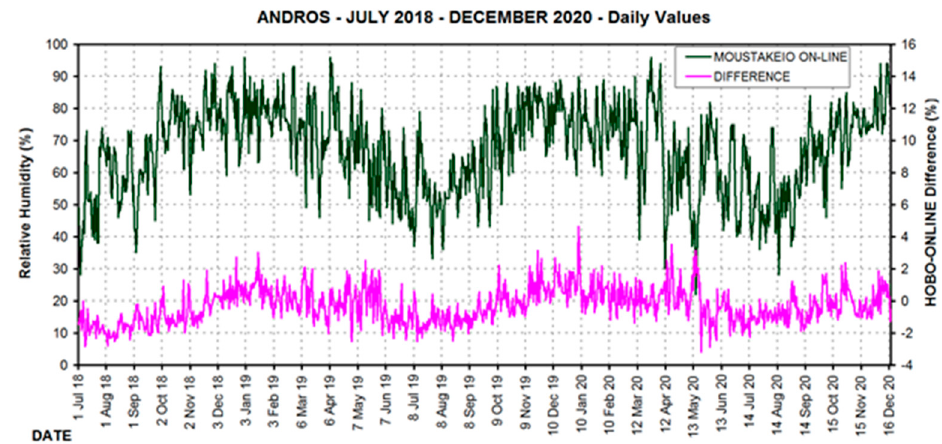
Figure 3. Plot of daily mean values of relative humidity at Moustakeio central online station (green line) with differences of the smal HOBO sensor from the central on-line station (purple line).